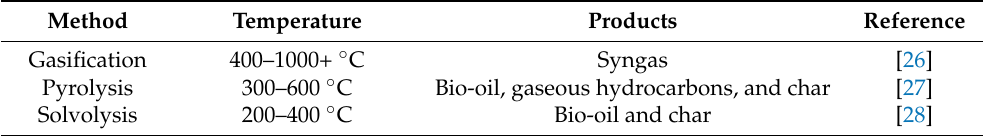
Table 2. Temperatures and main products from the most common thermochemical lignin depolymer- ization